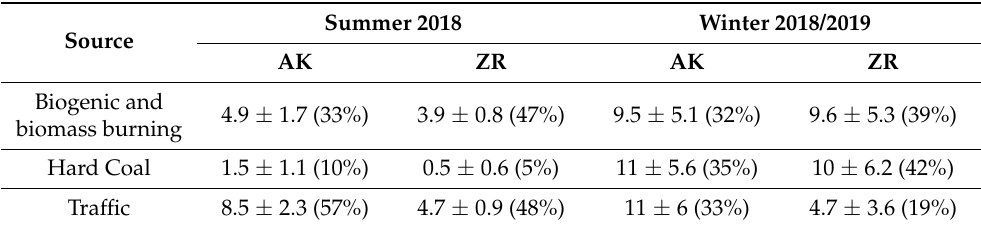
Table 2. The contribution of carbon sources in PM 10 at both stations during summer and winter season (in µ g/m 3 ± St.dev . and in %) calculated using isotope mass balance equations.